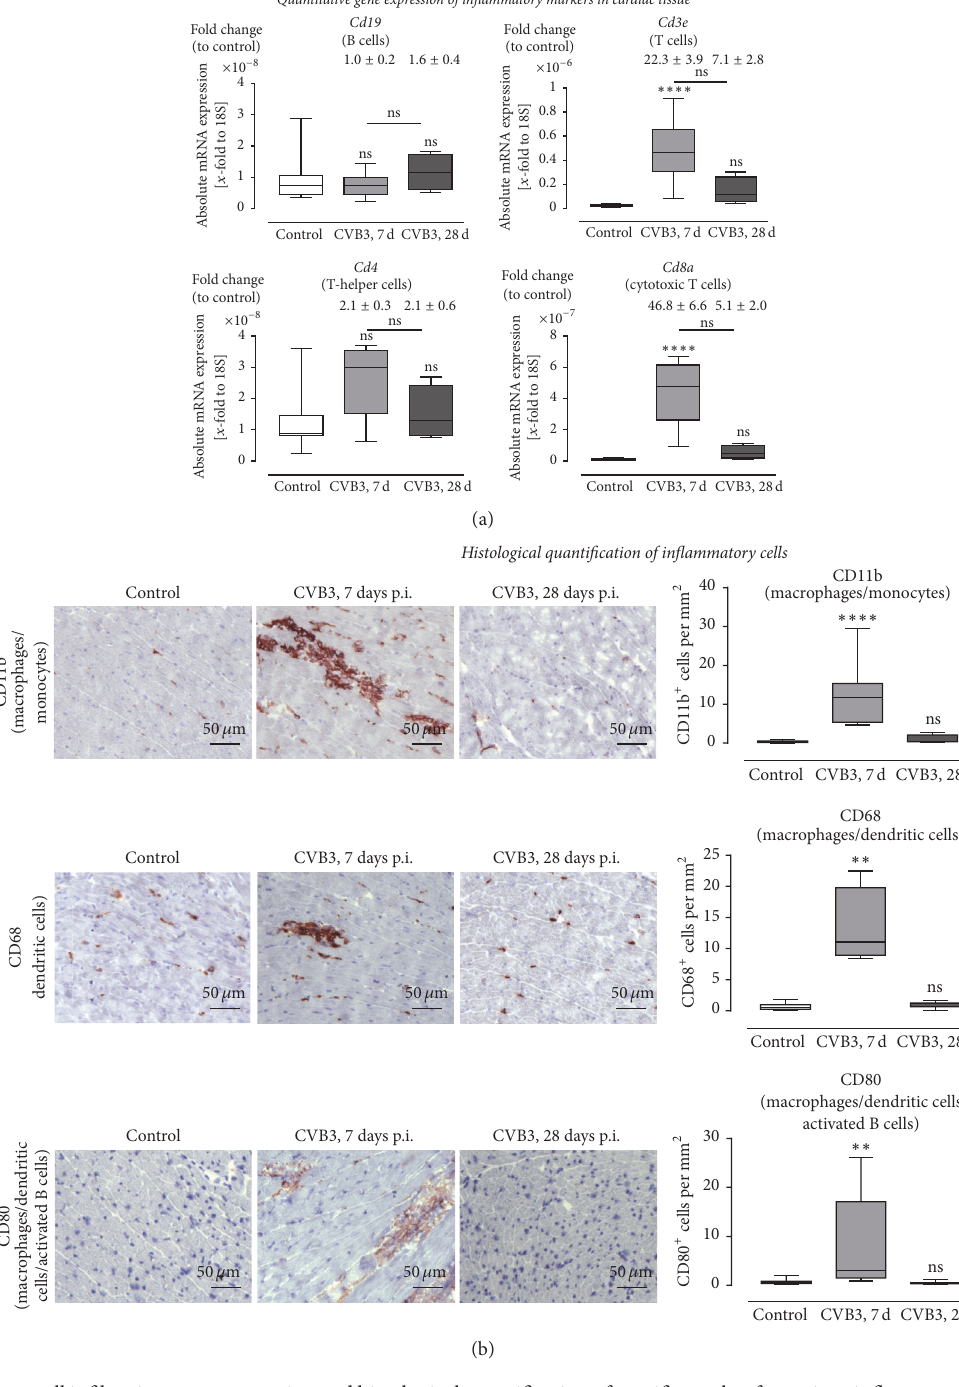
Figure 3: Immune cell infiltration: gene expression and histological quantification of specific marker for various inflammatory cells in cardiac tissue of CVB3-infected mice 7 and 28 days after infection. (a) Gene expression analysis of specific marker for various immune cells. The gene expression of Cd3e , as a marker for T cells in general, was highly increased 7 days after infection. Subsequent analysis of Cd4 and Cd8a expression revealed that CD8 + cytotoxic T cell represents the predominant T cell population within the cardiac tissue during the acute phase of viral myocarditis. Furthermore, Cd19 expression, as a marker for B cells, was not increased 7 and 28 days after infection. (b) Detailed images of murine cardiac tissue stained for different cell surface markers of immune cells. Immune cells were quantified and plotted as positive cells per mm 2 . Tissue sections stained for CD11b + , CD68 + , and CD80 + cells revealed significantly increased numbers 7 days after CVB3 infection compared to healthy controls. 28 days after infection no increased inflammation was detectable. The white bar represents healthy C57BL/6J mice, and grey bars represent mice infected with CVB3 for 7 days (light grey) or for 28 days (dark-grey). Data are presented as box plots; ∗ significantly different compared to noninfected mice (control); ∗∗ 𝑃 < 0.01 ; ∗∗∗∗ 𝑃 < 0.0001 ; ns not